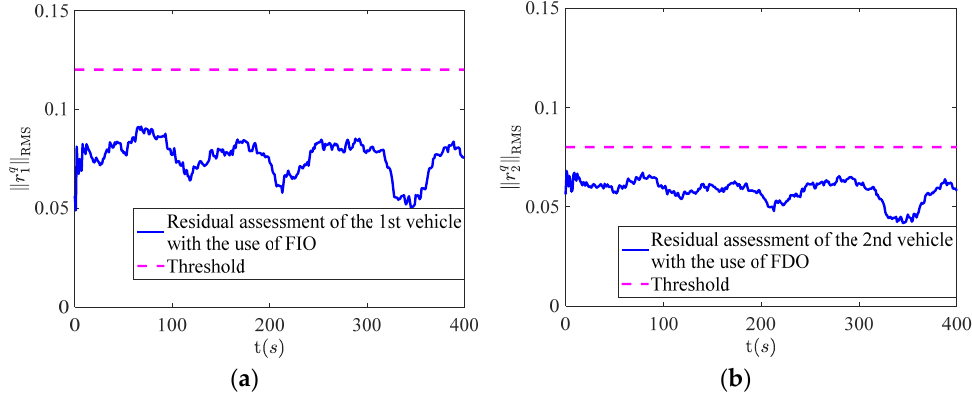
Figure 6. The results of fault isolation, where ( a ) represents the 1st vehicle with the use of FIO; ( b ) represents the 2nd vehicle with the use of FDO.